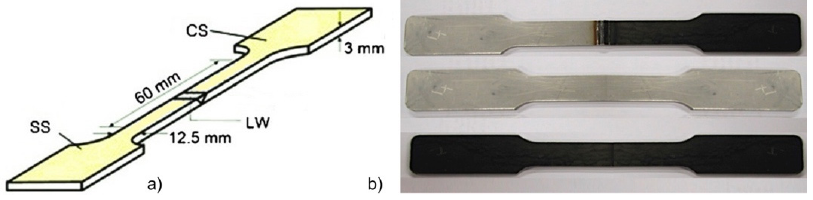
Figure 2. Tensile testing specimen. ( a ) Sketch of the transverse-welded flat tensile specimen; ( b ) image of tensile specimens (from top to bottom: containing the dissimilar joint, from SS, and CS).